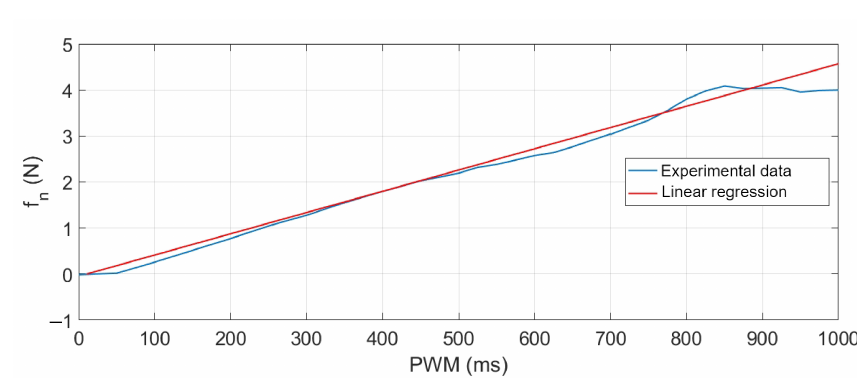
Figure 10. Experimental thrust curve for Emax brushless motor